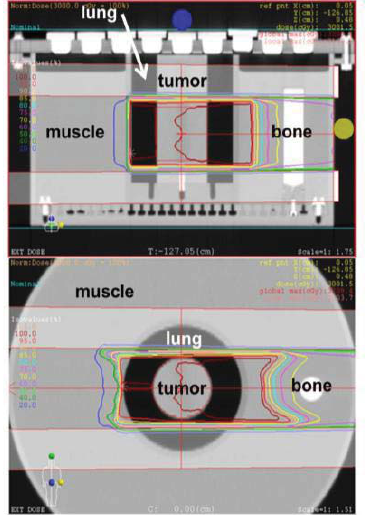
Figure 7. Dose distribution in inhomogeneous phantom including equivalent materials such as lung, bone and